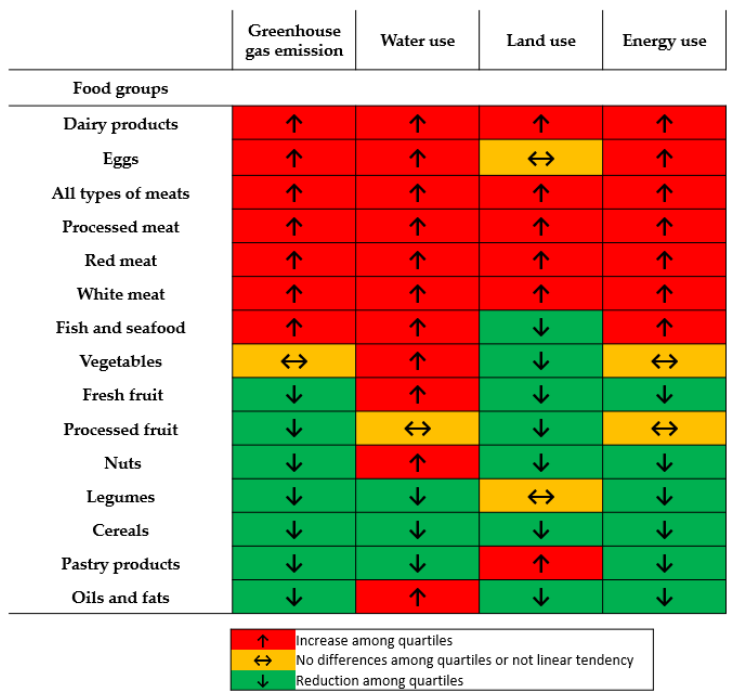
Figure 1. Tendencies in food groups’ consumption among energy-adjusted quartiles of the indicated environmental impact indicators. Specific food products, and their serving sizes, collected in each food group is described in Supplementary Table